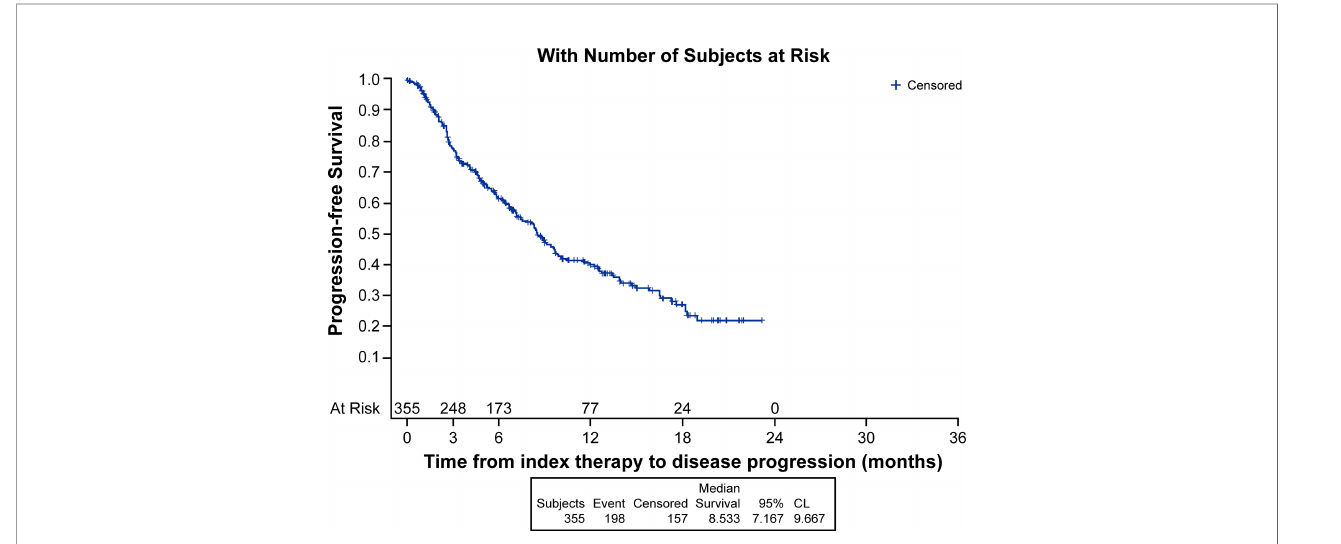
FIGURE 1 | Kaplan-Meier analysis of real-world progression